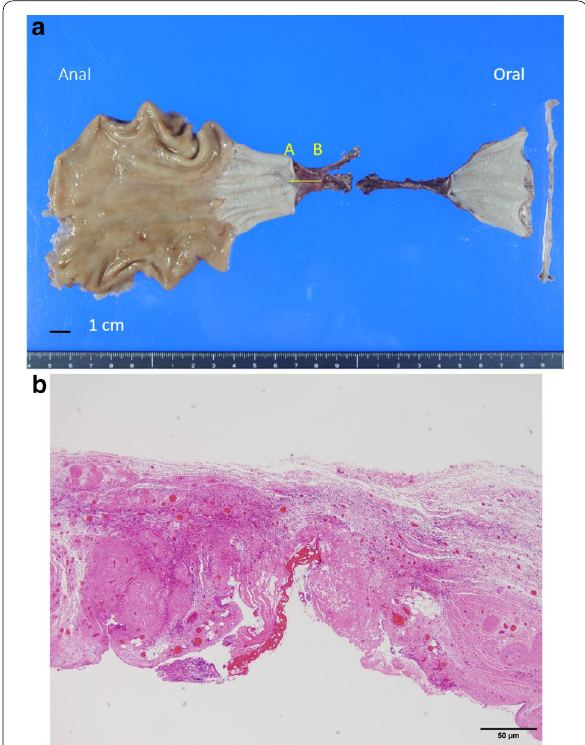
Fig. 7 Histopathological findings. a Gross findings of the resected specimen revealing the disruption of the esophageal epithelium for approximately 75 mm in the middle thoracic esophagus. b Microscopic examination of the area denoted with the yellow line (from a to b ) in Fig. 6a (hematoxylin and eosin staining; magnification, 100) revealing no esophageal structures and × replacement of esophageal epithelium by hyalinosis and